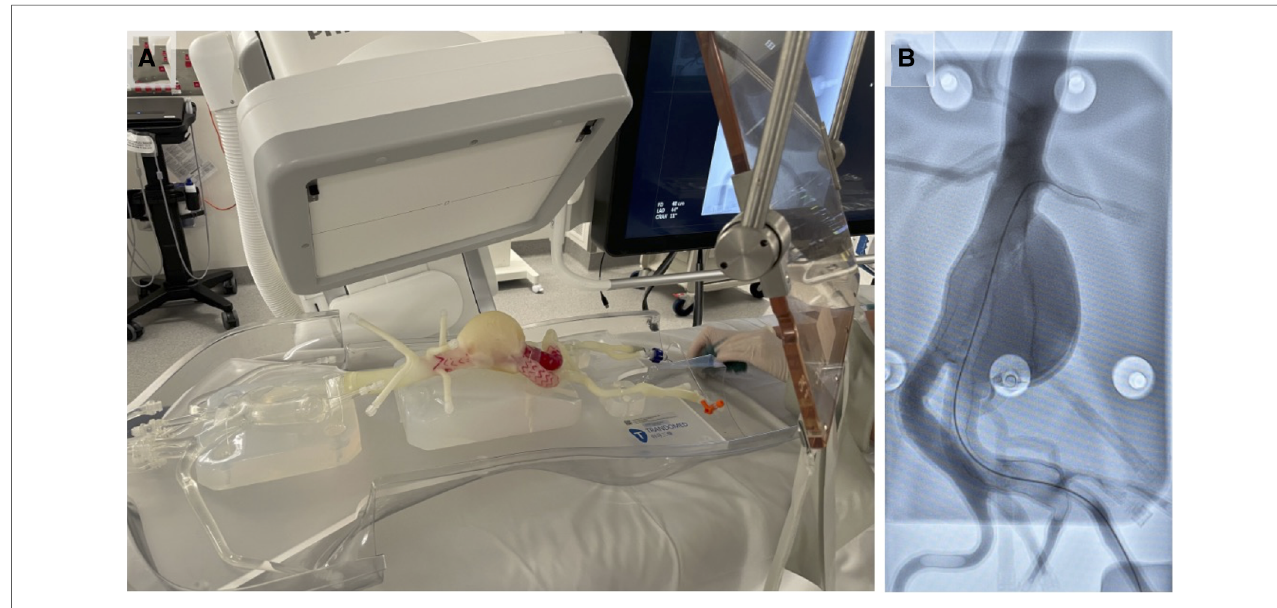
FIGURE 6 Example application of M3DP abdominal aortic aneurism (AAA) model for surgical training. ( A ) Perfused AAA model situated under x-Ray C-Arm and ( B ) representative x-Ray image showing contrast-enhanced model and surgical guide